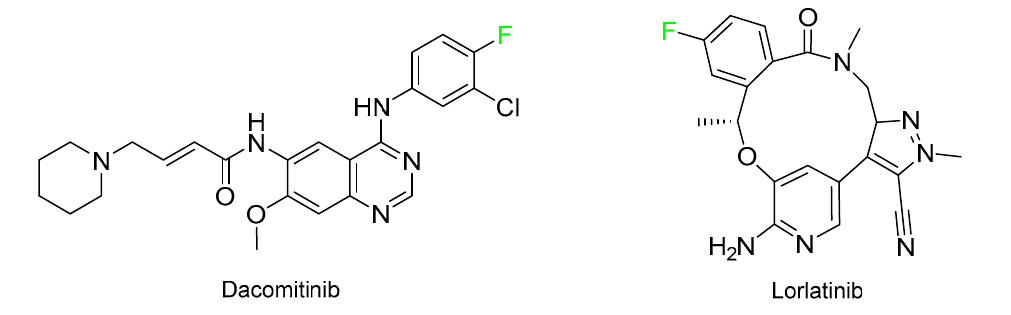
Figure 16. Structure of drugs for NSCLC.